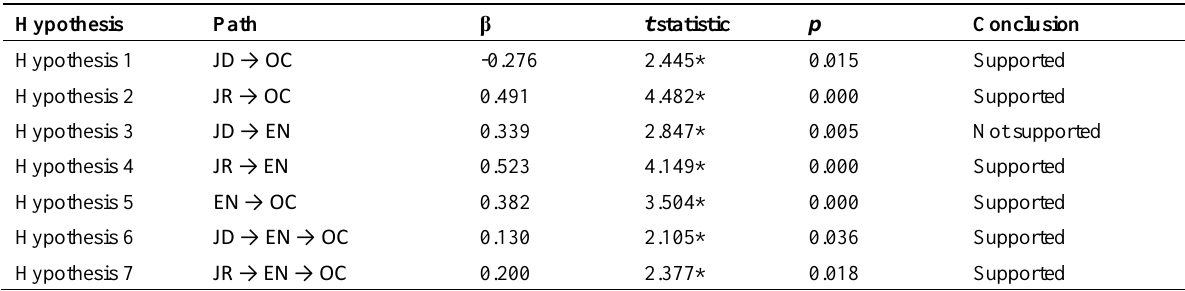
Table 4: Hypotheses